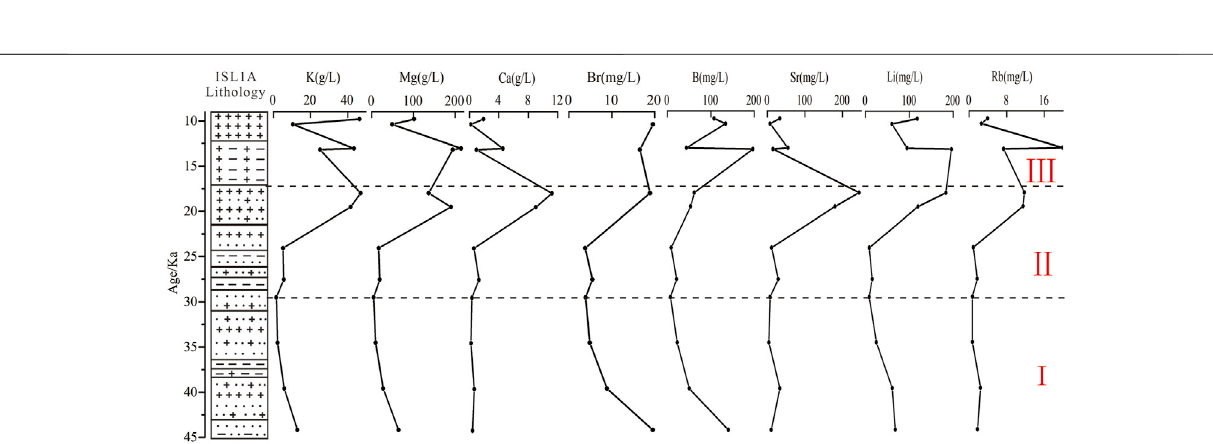
Frontiers in Earth Science |